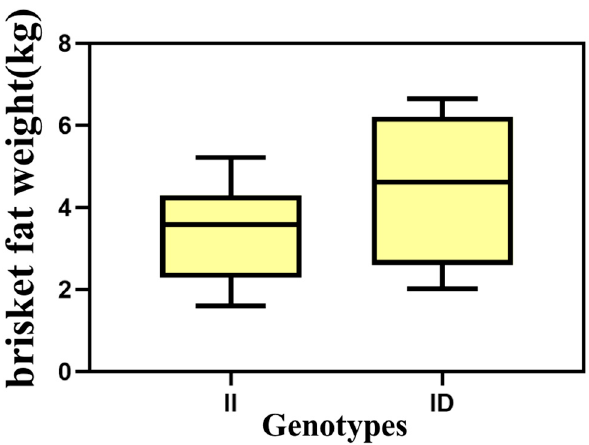
Figure 11. Association of the P2-Del-8-bp InDel with carcass traits in the female SDBCGR population.